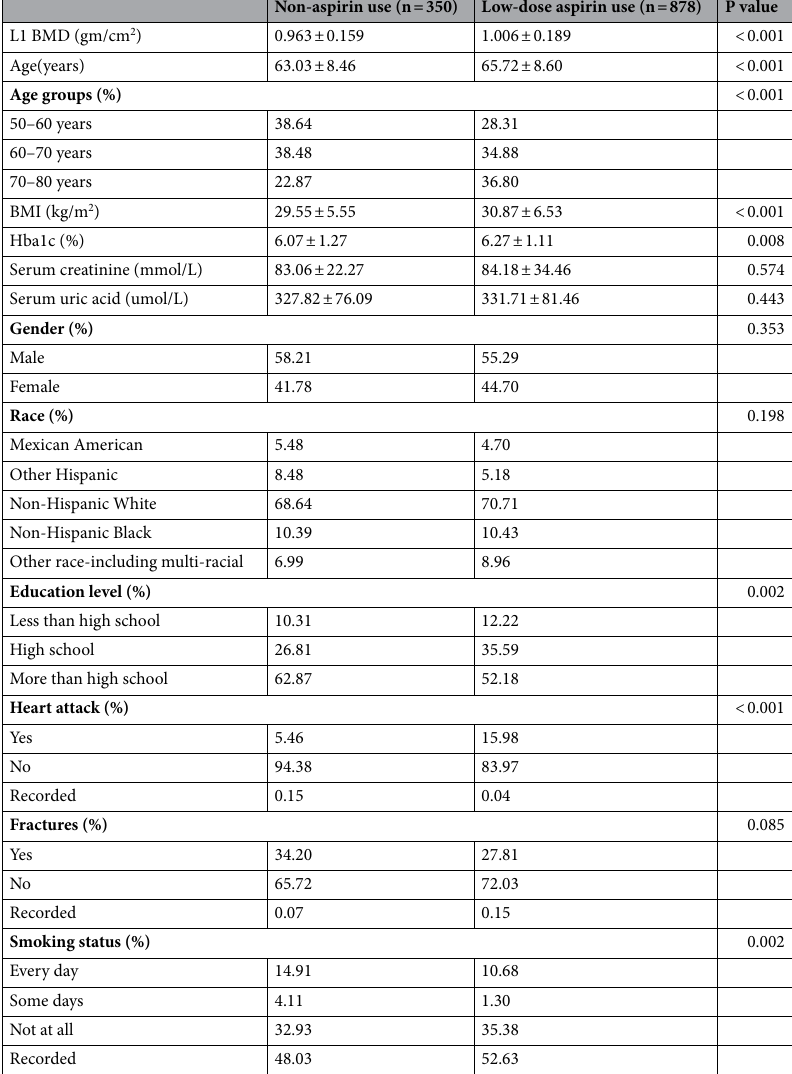
Table 2. Weighted characteristics of study sample non-aspirin users and low-dose aspirin users (Group2: L1BMD). Mean ± SD for continuous variables: P value was calculated by the weighted linear regression model. Per cent for categorical variables: P value was calculated by weighted chi-square test. Weights are created in NHANES to account for the complex survey design (including oversampling), survey non-response, and post- stratification adjustment to match total population counts from the Census